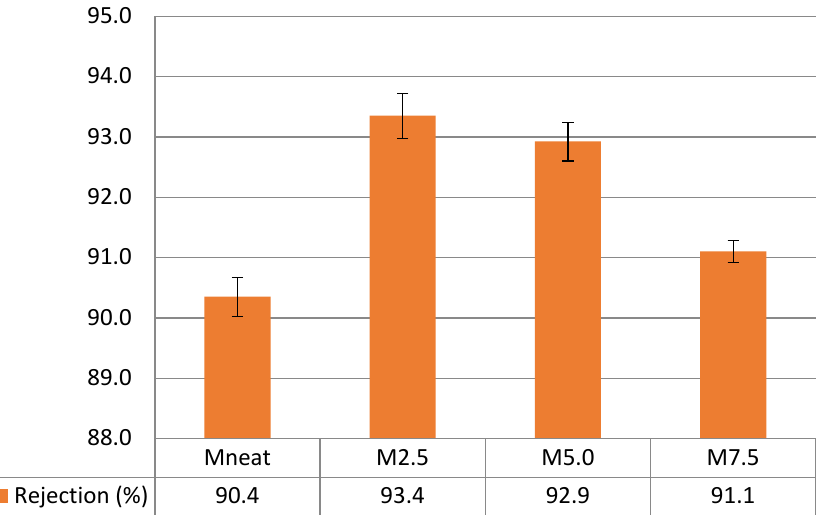
Figure 8. BSA rejection of M2.5, M5.0, and M7.5 AHFM in comparison with MNeat membrane ( n = 3).